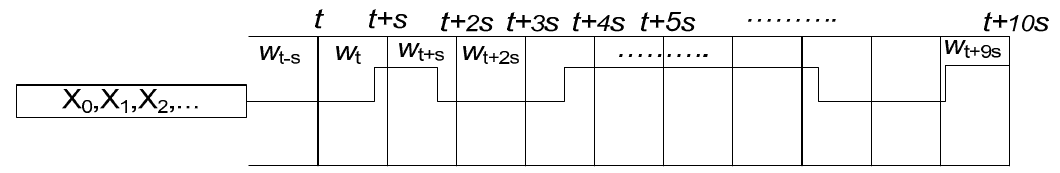
Figure 3. A fixed sliding window technique .